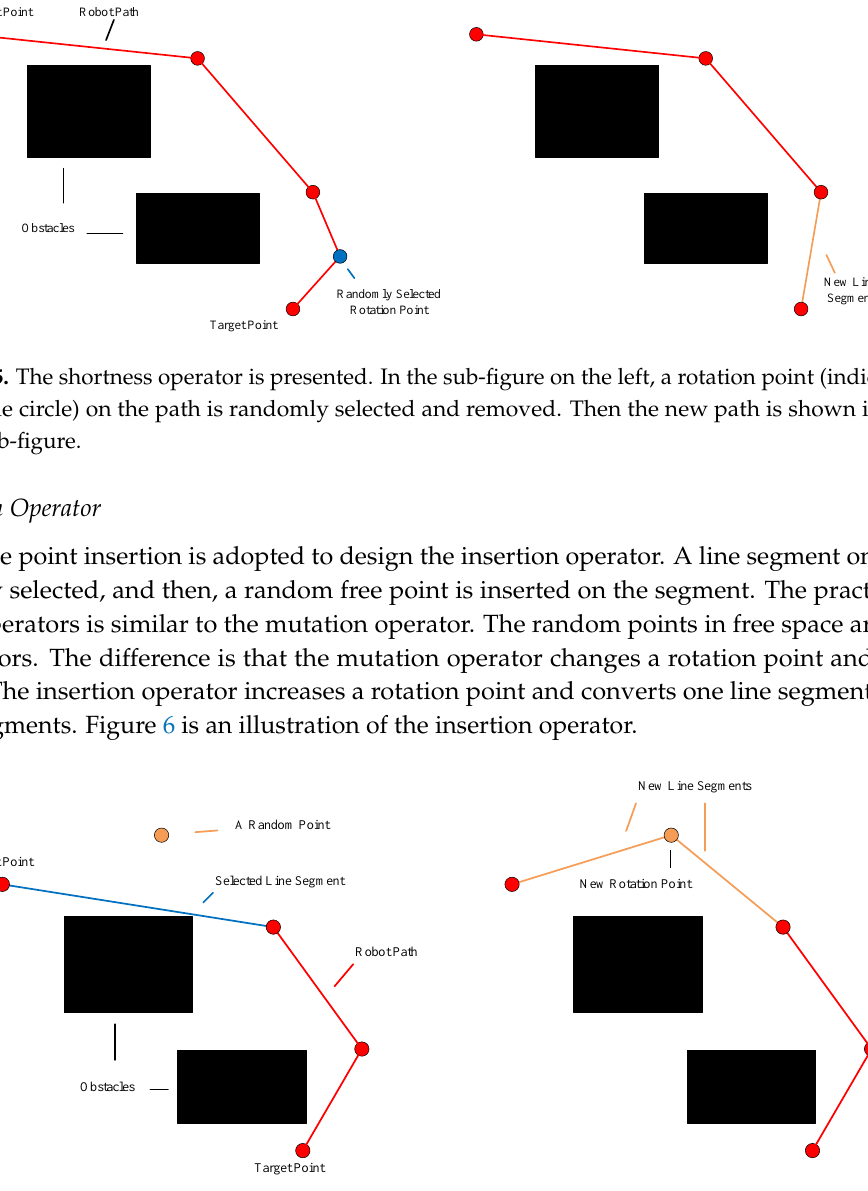
Figure 6. The insertion operator is shown. In the left sub-figure, a line segment on the path is randomly selected and indicated by a blue line. A free point is randomly generated in space and inserted into the blue line segment. The generated path is shown in the right